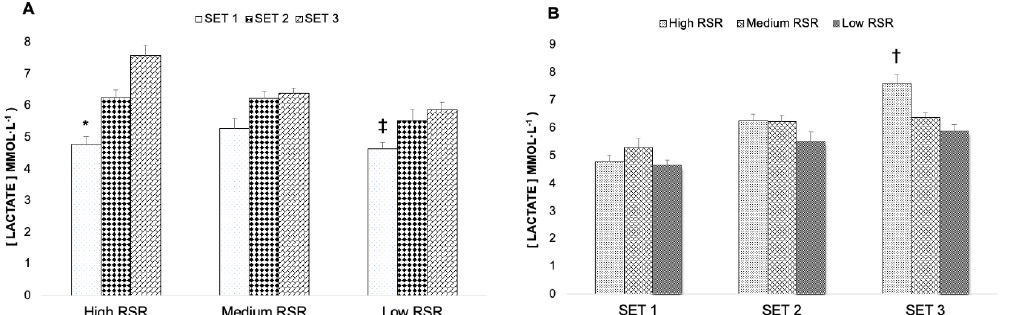
Figure 4. ( A ) Comparison of the blood lactate concentrations between strength level groups for each set, ( B ) comparison of blood lactate between sets for each strength level group. * = significant difference between all sets ( p < 0.05). ‡ = significant difference between set 1 and set 3 ( p < 0.05). † = significant difference between High RSR and Low RSR ( p < 0.05).